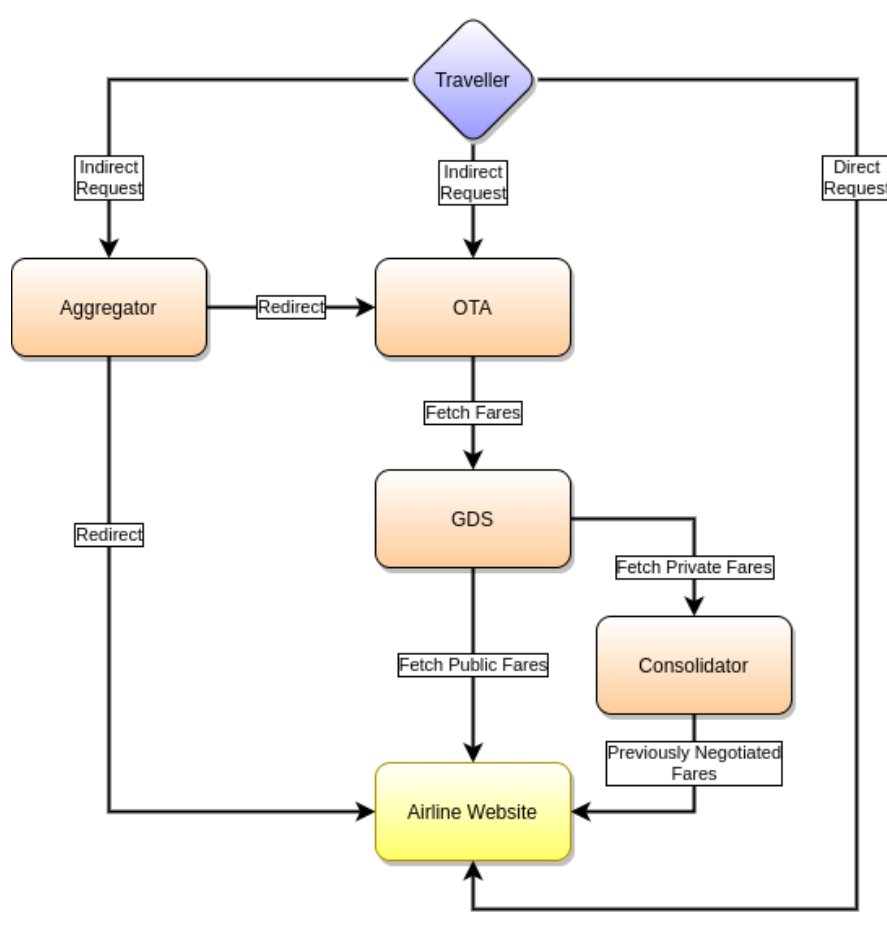
Figure 1. Ticket Distribution